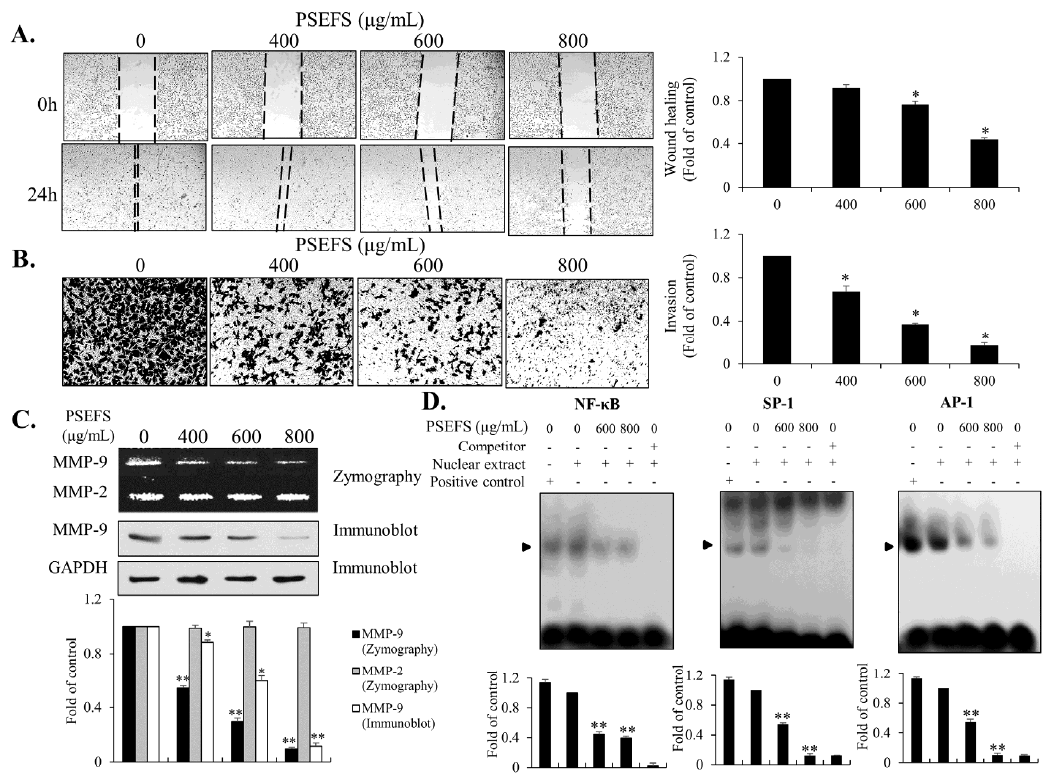
Figure 4. PSEFS inhibits T24 cell migration and invasion by reducing MMP-9 activity and expression through transcriptional repression. T24 cells were incubated with the indicated concentrations of PSEFS for 24 h. ( A ) Migratory potential was investigated (40 × magnification) by a wound-healing migration assay. ( B ) T24 cell invasiveness was estimated using a Matrigel-coated chamber transwell assay. ( C ) Both MMP-2 and MMP-9 activity were assessed by gelatin zymography. Relative protein levels of MMP-9 were examined by immunoblot. ( D ) Investigation of DNA binding by SP1, NF- κ B, and AP-1 to the cis-element of the MMP-9 promoter according to EMSA. Data represent the mean ± SD of triplicate experiments. * p < 0.05, ** p < 0.01 vs. control.